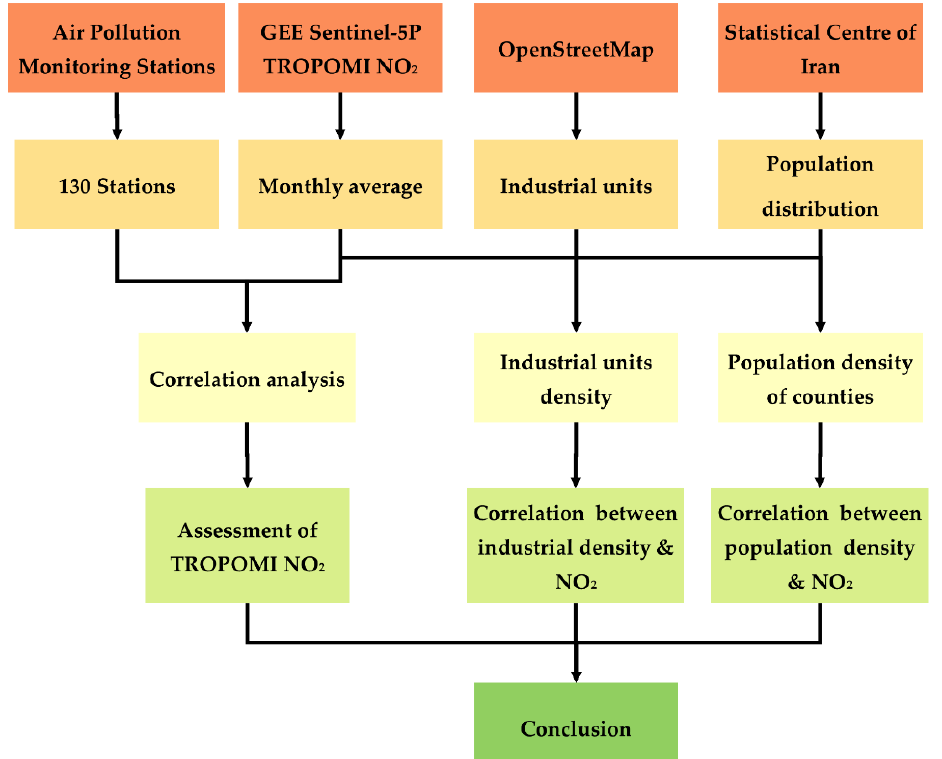
Figure 3. The flowchart methodology of this research.